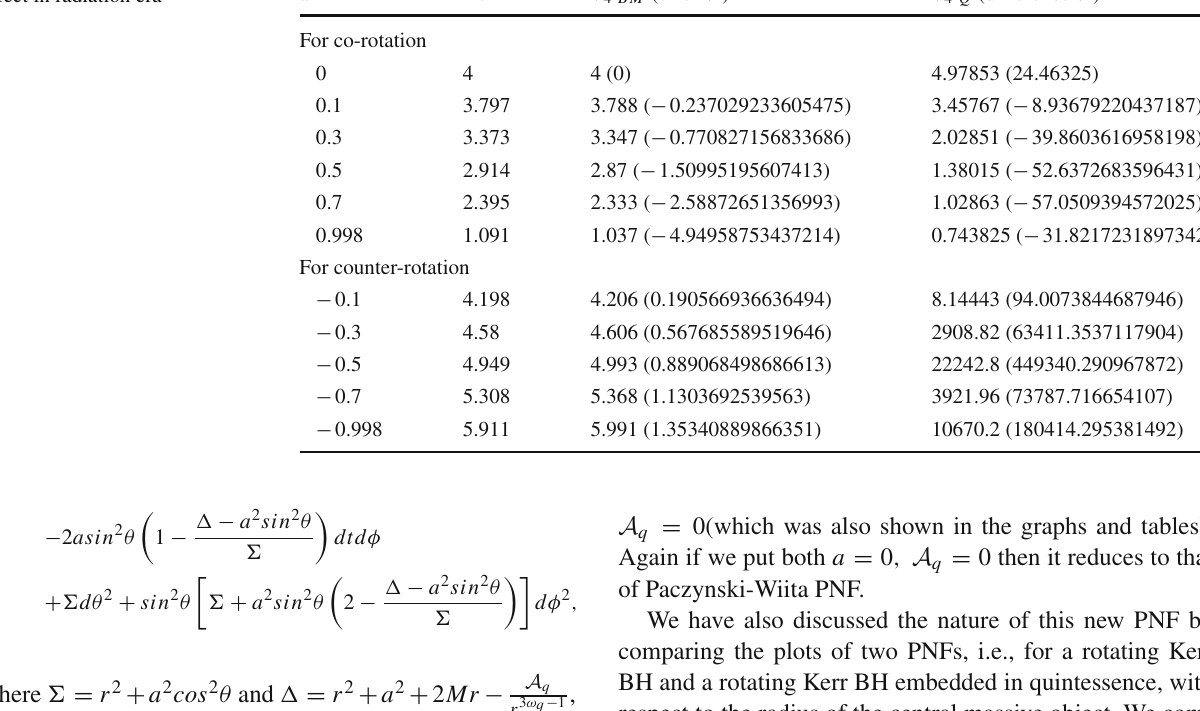
PNPs for relatively high DE effect in radiation era